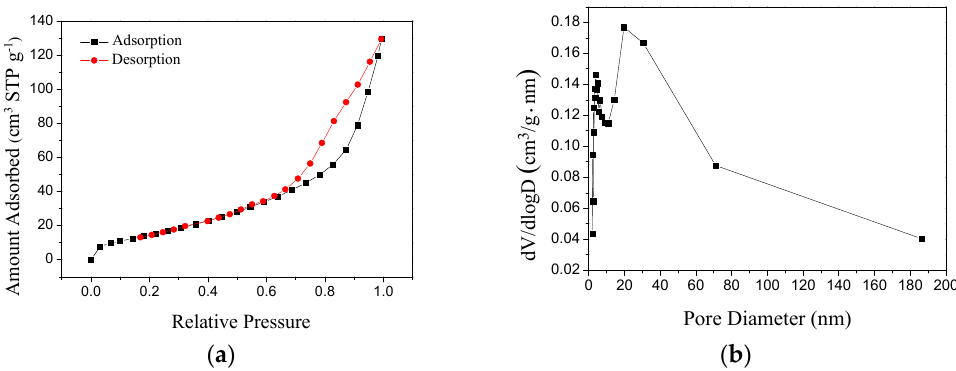
Figure 7. Nitrogen absorption–desorption isotherm ( a ) and the pore size distribution ( b ) of the sample.